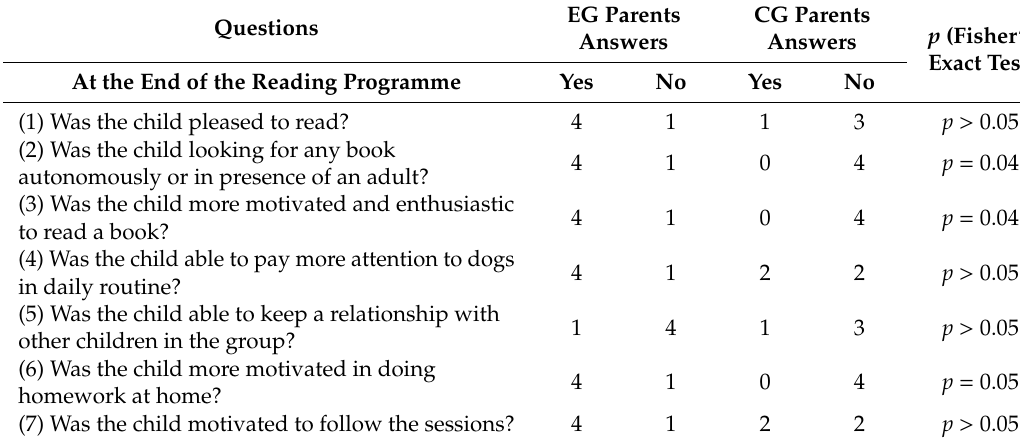
Table 3. Parent-completed